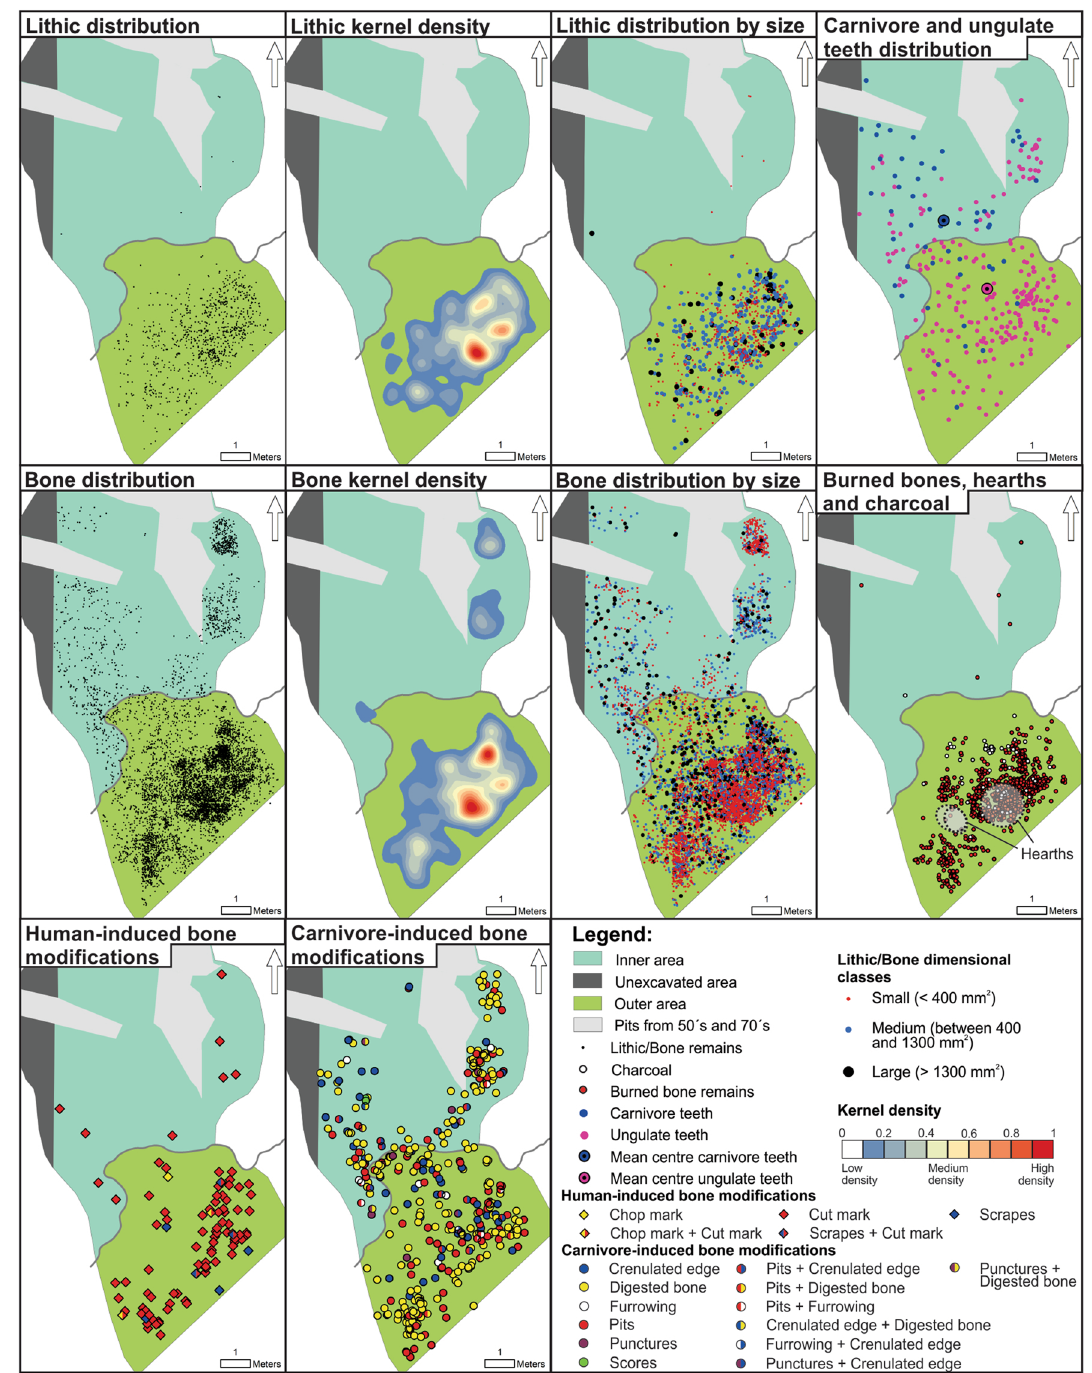
Figure 6. Spatial distribution of lithic artefacts, faunal specimens, burned bones, hearths, charcoal, carnivore/ ungulate teeth, and human/carnivore-induce modifications on bones from subunit III-a1. The figure was prepared with the ArcGIS Version 10.5 software and the Adobe Photoshop CS5 Version 12.0.4